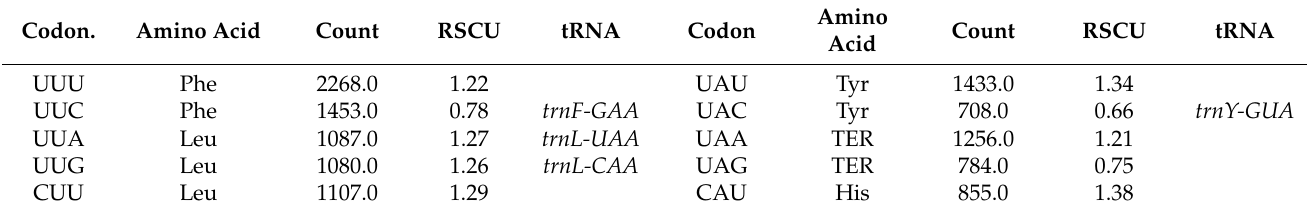
Table 4. Codon—anticodon recognition patterns and codon usage of the P. angulata var. villosa plastome.